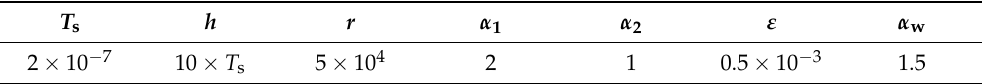
Table 2. Design parameters of the composite nonlinear speed controller.